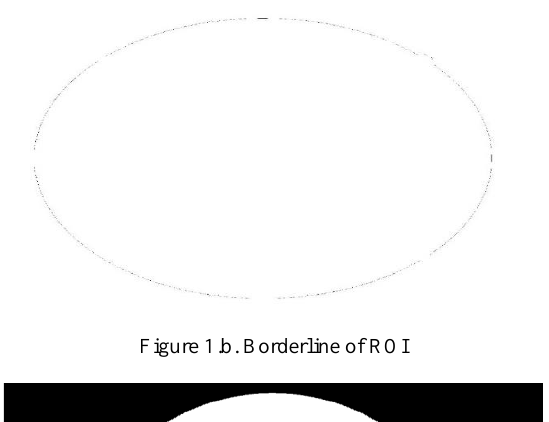
Figure 1.a. Original input image (RGB)